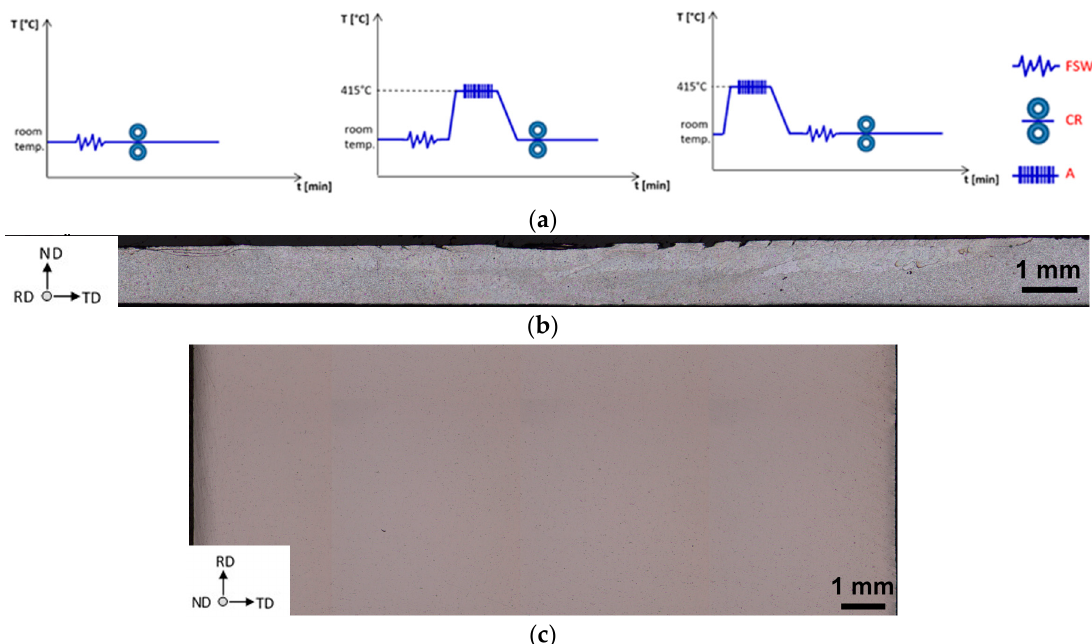
Figure 2. Schematic representation of the thermo-mechanical processes. ( a ). Optical microscopy (OM) of the FSW 1 ( ω = 600 rpm, v = 200 mm/min) after annealing at 415 °C/3 h (A) and cold rolling (CR) to ε ∼ 1.08 (FSW 1 -A-CR), of the AA5754 sheet section, where the retreating side (RS) is on the left-hand side, and the advancing side (AS), on the right-hand side, ( b ). Central region top surface, corresponding to the nugget zone (NZ), i.e., the bottom FSW surface, corresponding to the one CRed at the top roll cylinder, ( c ). Both lateral section and top FSW-CR surface did not show crack formation after CR.